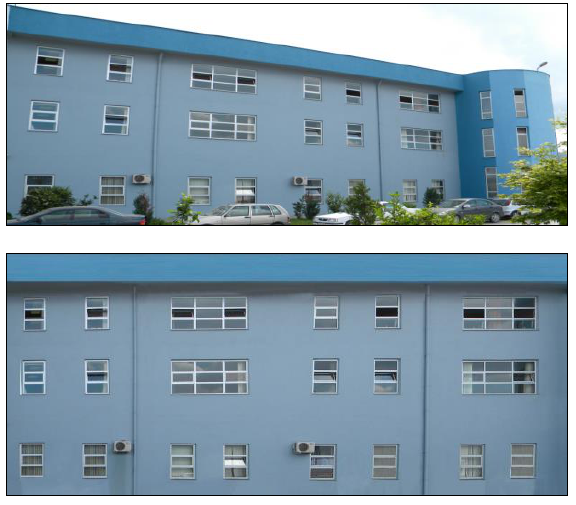
Figure 10. Image optimization before and